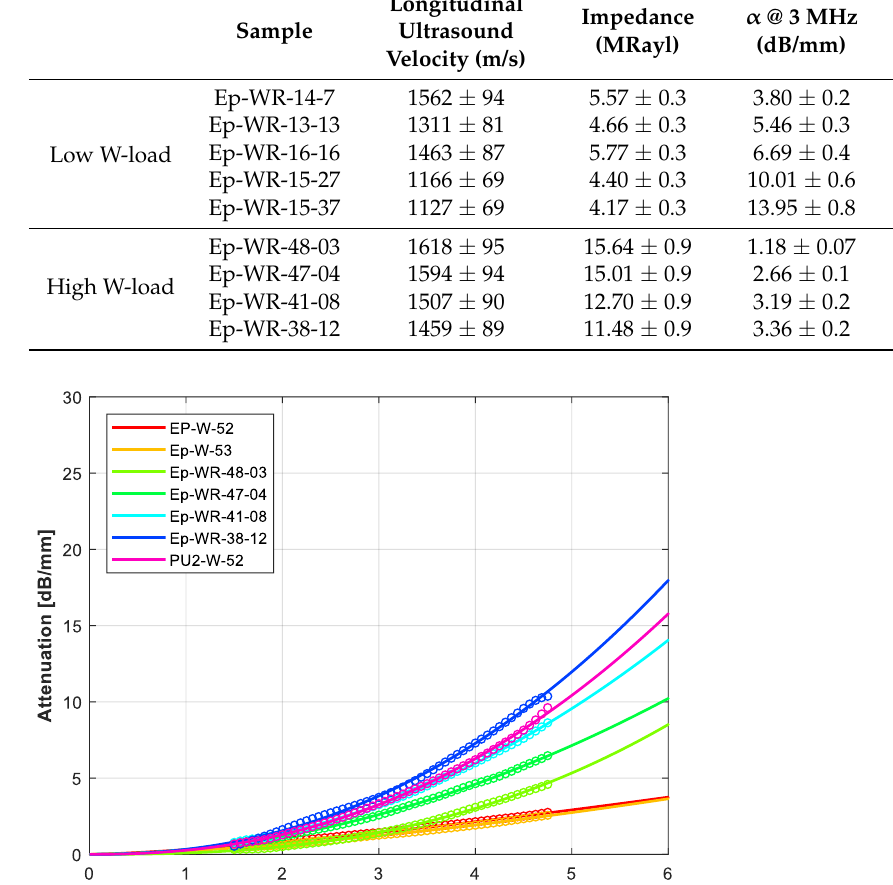
Figure 6. Variation in the ultrasonic attenuation coefficient with the frequency for the rubber + tungsten-loaded epoxy resin composites. High impedance series. Open circles: measurements. Solid line: fitting using a power law.